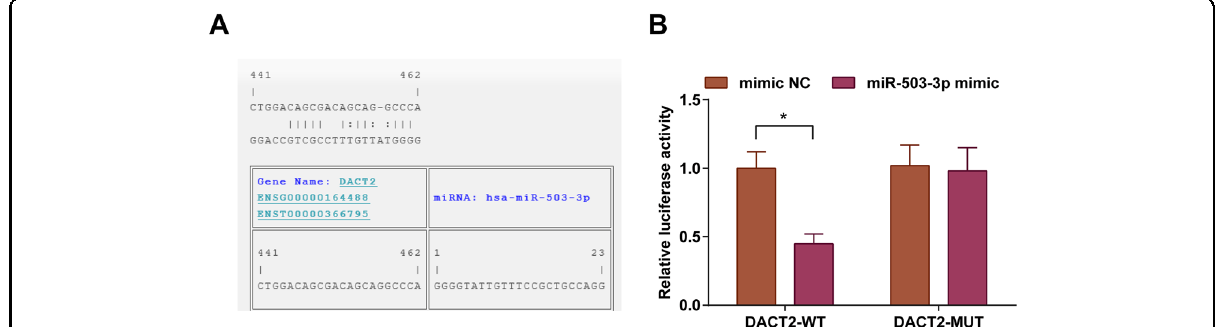
Fig. 2 DACT2 is a direct target gene of miR-503-3p. A Online binding sites of miR-503-3p and DACT2; B dual-luciferase reporter gene assay veri fi ed the target relation between miR-503-3p and DACT2; * P < 0.05; the measurement data were expressed as mean ± standard deviation and compared using Student ’ s t